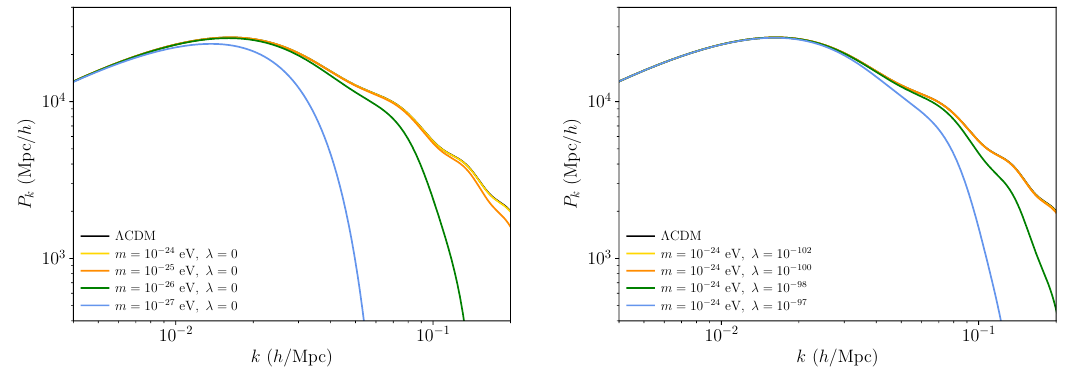
Figure 3 . Matter power spectrum. On the left, results for a massive scalar (cid:12)eld without self- interaction. On the right, results for di(cid:11)erent self-interaction strengths for a mass that is indistin- guishable from CDM with (cid:21) = 0.